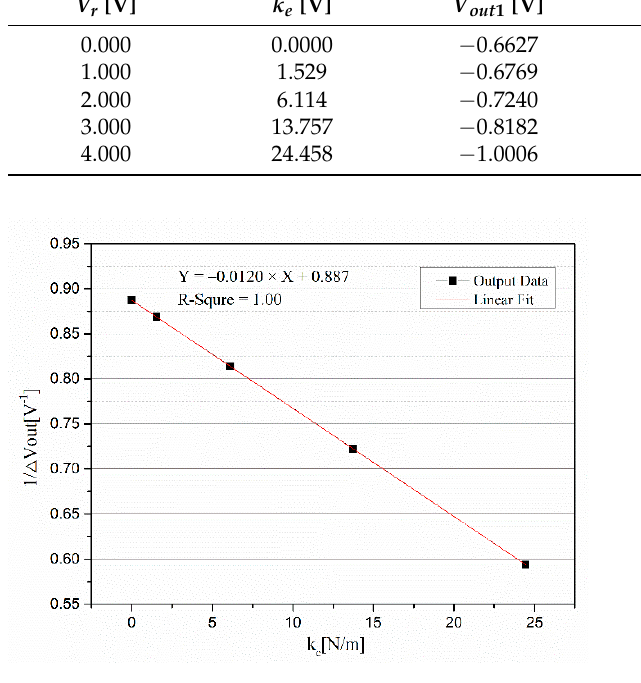
Figure 8. Curve of measuring the mechanical stiffness.